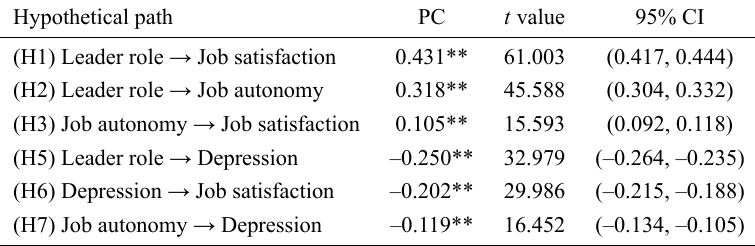
Table 3. Results of hypotheses testing in regular employees.